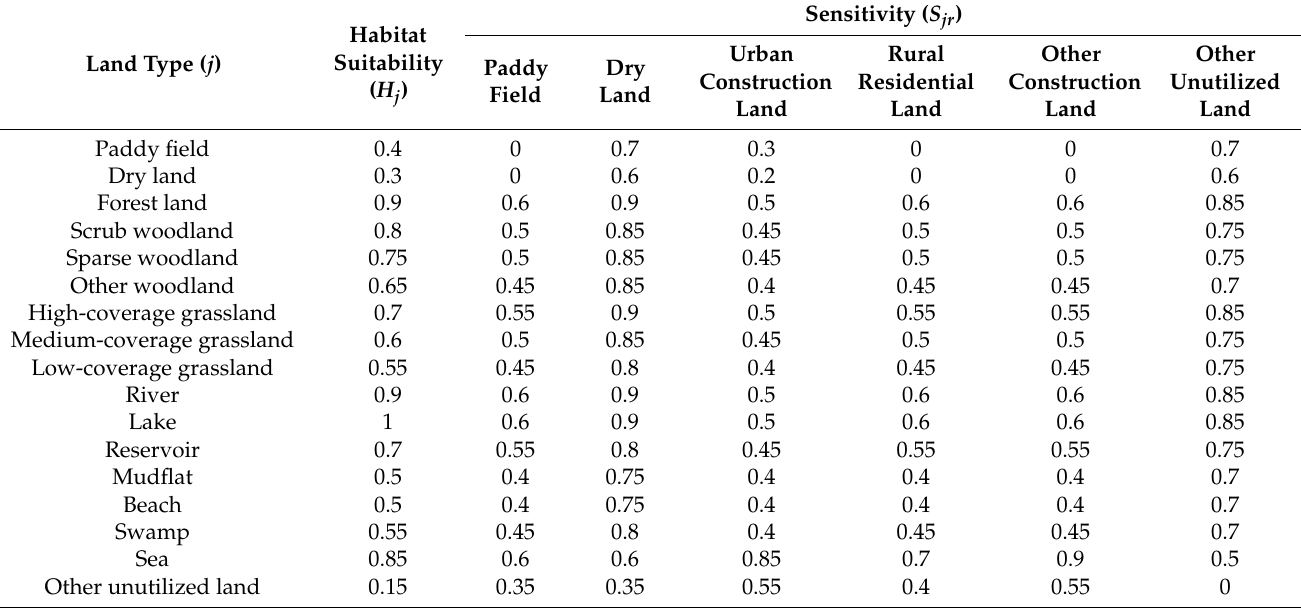
Table 2. Habitat suitability of land use types and their sensitivity to threat